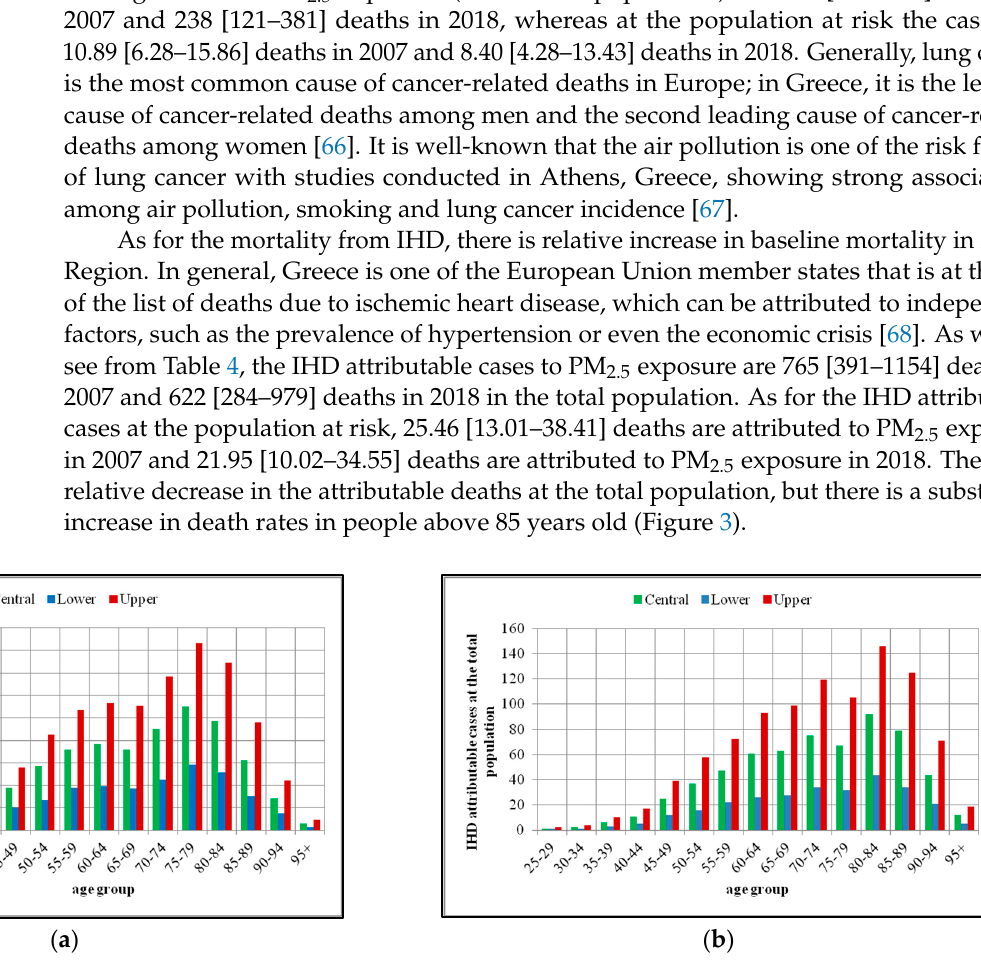
Figure 3. IHD mortality cases (at the total population) per age group attributable to PM 2.5 exposure for ( a ) 2007 and ( b ) 2018.